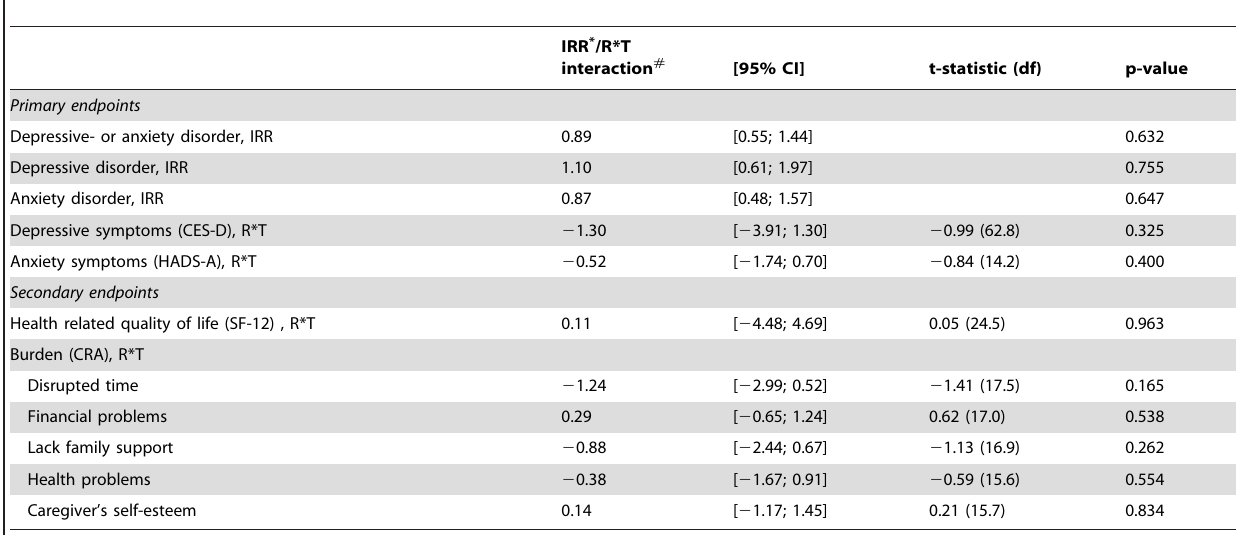
Table 4. Per protocol analyses on the primary and secondary outcome